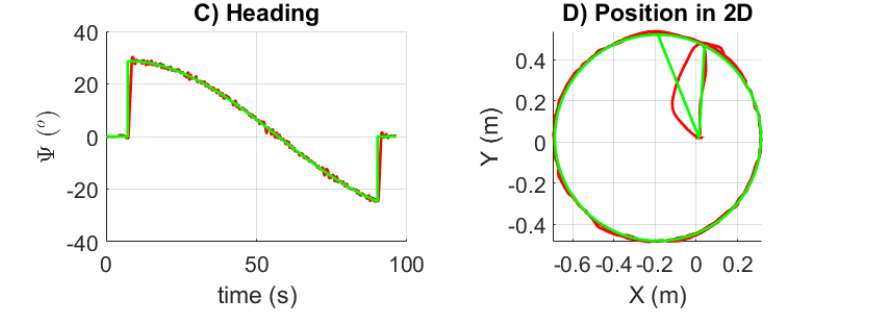
Figure 12. ( A – C ) plots of the position and orientation of the mobile robot. The accurate measurements provided here only by means of the Vicon system provide to the sliding mode nonlinear controller the measured robot’s positions ( x , y ) and heading. The path is compared to the desired trajectory.